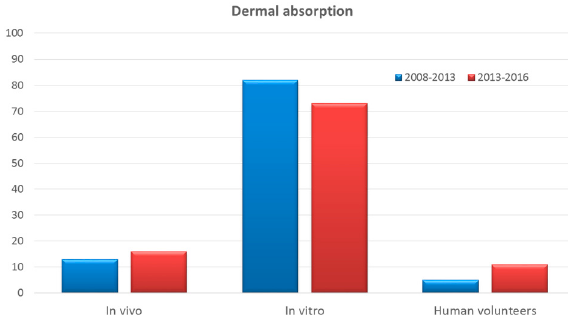
Figure 4. Evolution of the percentage of studies performed in vivo, in vitro and in human volunteers to evaluated dermal absorption of cosmetic ingredients—number of studies 86 (2008–2013) and 44 (2013–2016).